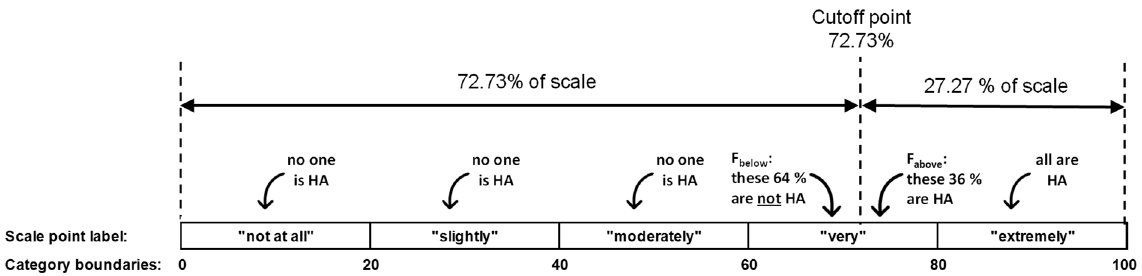
Figure 3. Cutoff point of 72.73% (which corresponds to the three uppermost scale points 8, 9, 10 on the 11-point scale) on the 5-point scale and assigned percentage of HA within the five categories “not at all,” “slightly,” “moderately,” “very,” “extremely.”